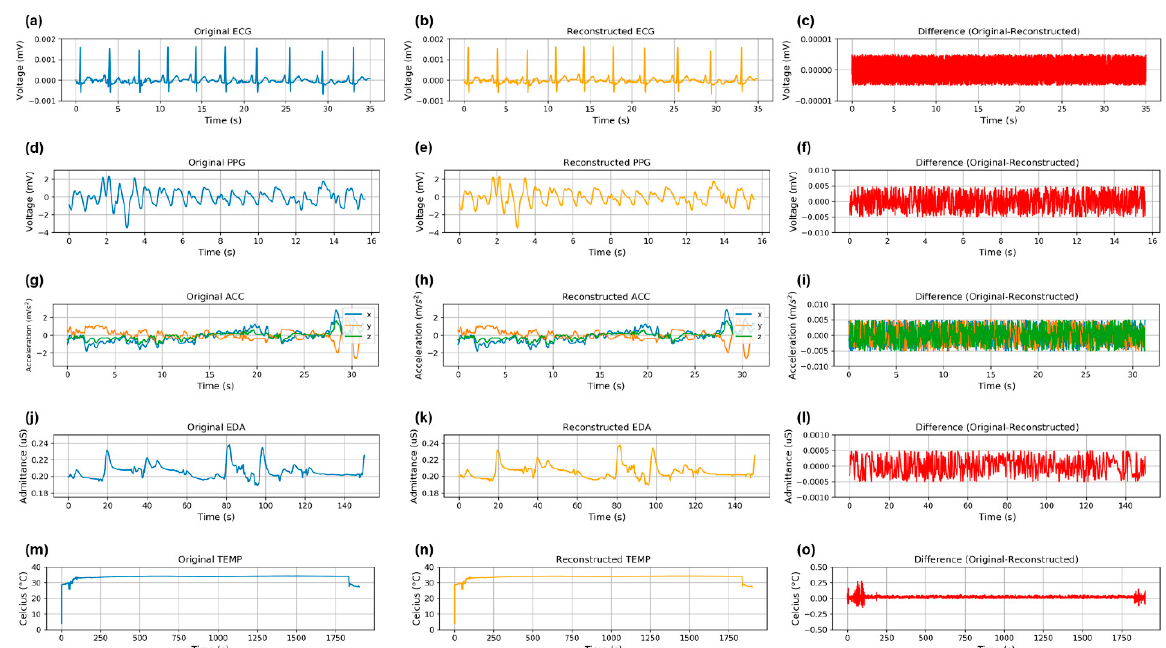
Figure 4. Comparison of original, reconstructed, and difference between original and reconstructed signals for ECG ( a – c ), PPG ( d – f ), ACC ( g – i ), EDA ( j – l ), and TEMP ( m – o ). These plots were constructed for the method that minimized the PRD: DDC with HE for ECG, PPG, ACC; SVD with HE for EDA; BD-WT with HE for TEMP. This figure enables visualization of the signal characteristics and corresponding differences between original and reconstructed signals.